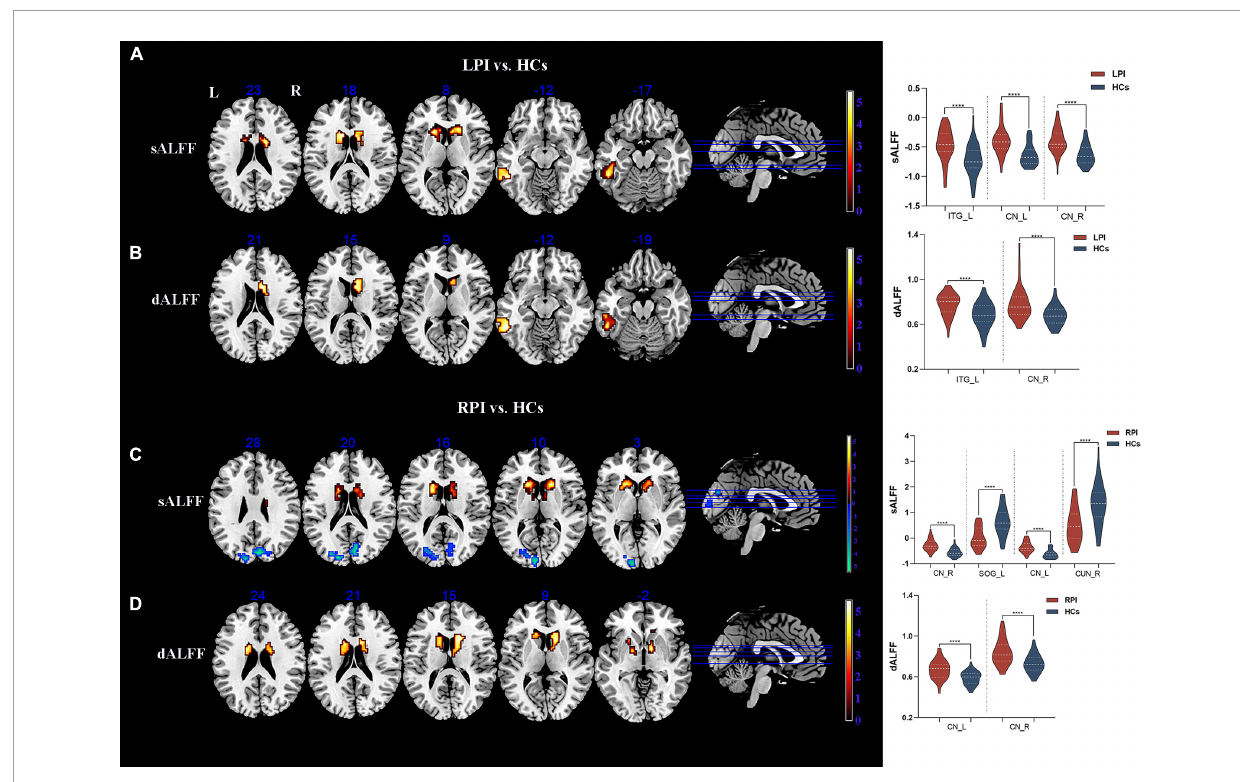
FIGURE2 sALFF/dALFF differences between pontine infarction (PI) and healthy controls (HCs) group. (A) Voxel-based analysis showed brain regions with significant sALFF alterations of LPI group. (B) Voxel-based analysis showed brain regions with significant dALFF alterations of LPI group. (C) Voxel-based analysis showed brain regions with significant sALFF alterations of RPI group. (D) Voxel-based analysis showed brain regions with significant dALFF alterations of RPI group. dALFF, dynamic amplitude of low-frequency fluctuations; LPI, left pontine infarction; RPI, right pontine infarction; sALFF, static amplitude of low-frequency fluctuations; ****Represents p -value <